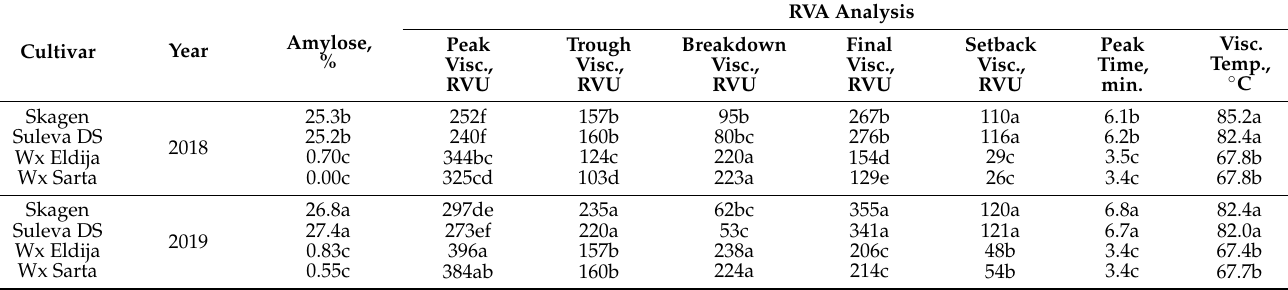
Table 3. Starch quality characteristics of non-waxy and waxy winter wheat cultivars grown in two cropping seasons (averaged data of two farming